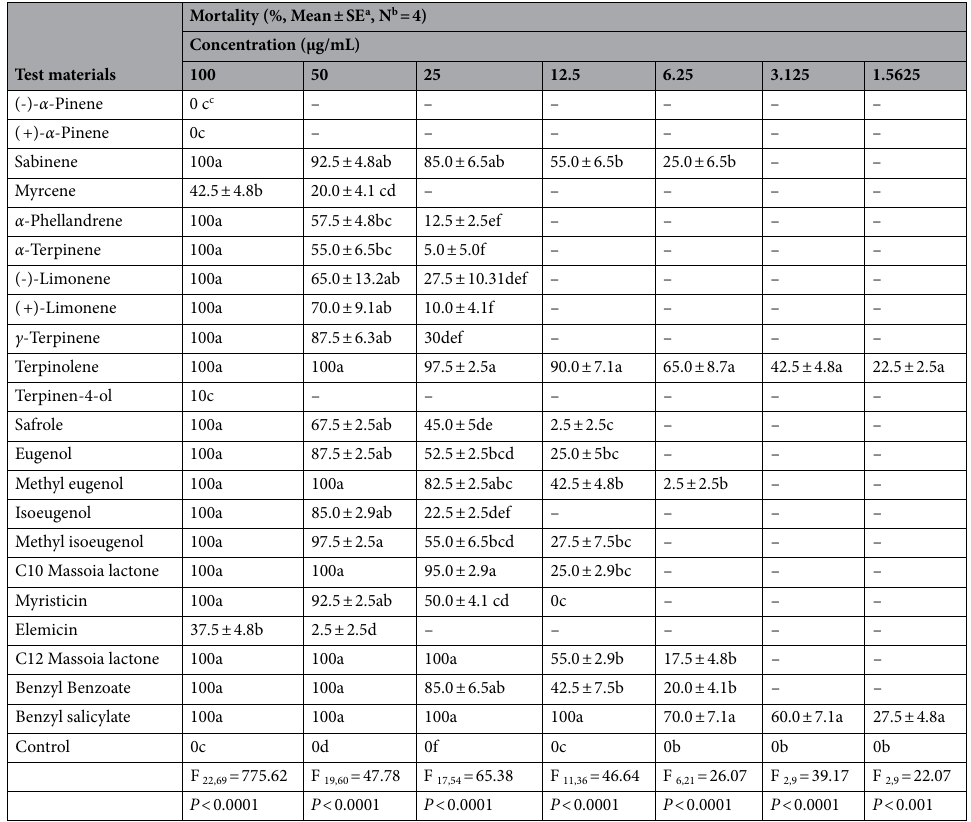
Table 3. Larvicidal activity of components identified in massoia and nutmeg EOs against Ae. albopictus . a Standard error of the mean; b Replication number; c Means within a column followed by the same letters are not significantly different (Scheffe’s